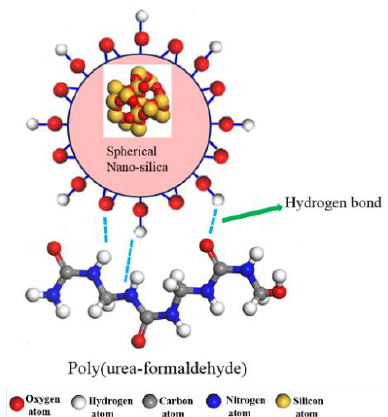
Figure 11. The schematic diagram of hydrogen bonds for the PUF–SiO 2 interfacial interaction. The PUF chain was constructed by three repeat units.